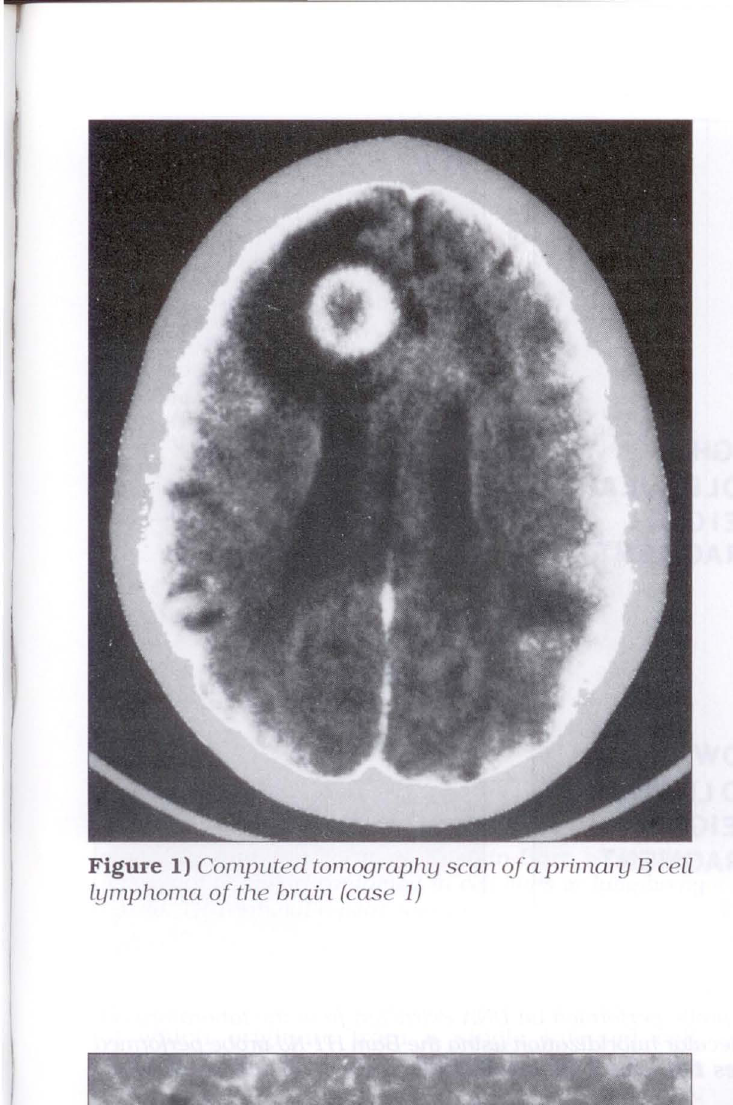
Figure 1) Computed tomography scan of a primary B cell lymphoma of ihe brain (case 1)